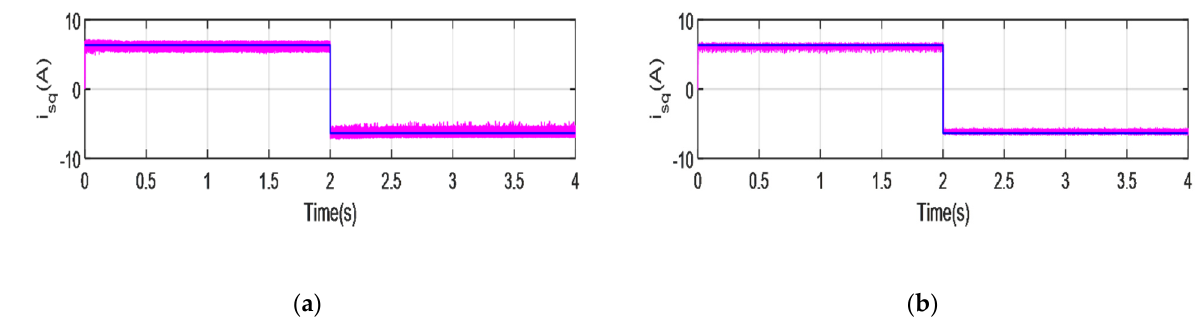
Figure 10. Isq components: ( a ) conventional inverter; ( b ) five-level inverter.